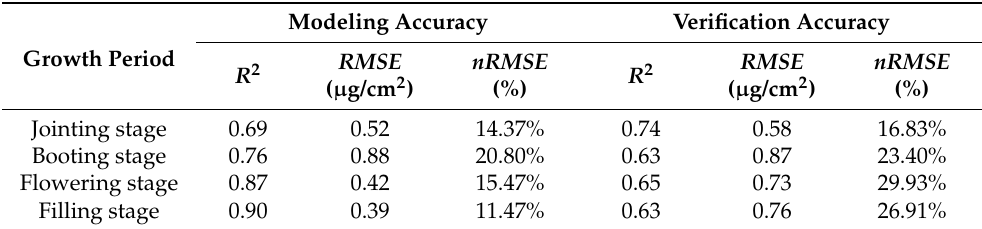
Table 3. Optimal subset regression modeling results of leaf area index estimation based on wavelet energy coefficient at different growth stages. Table 4. Estimation of leaf area index based on wavelet energy coefficient at different growth stages and modeling results of support vector